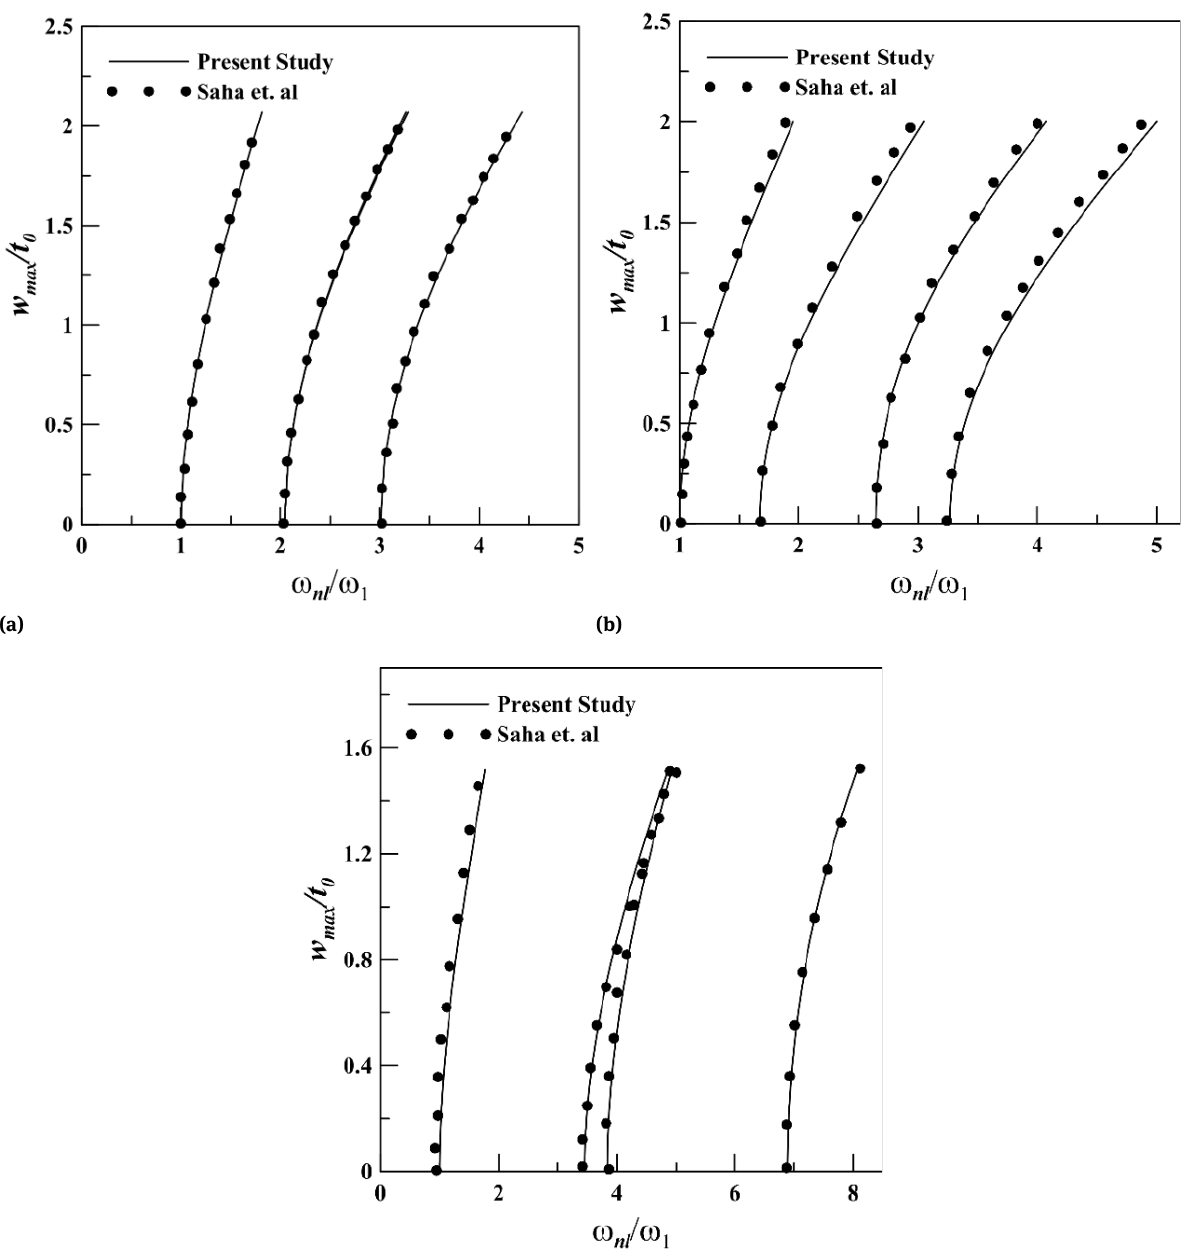
Figure 3: Comparison of first four Backbone Curves for uniformhomogeneous plate corresponding to (a) CCCC, (b)CCCF and (c) CCFF bound- ary